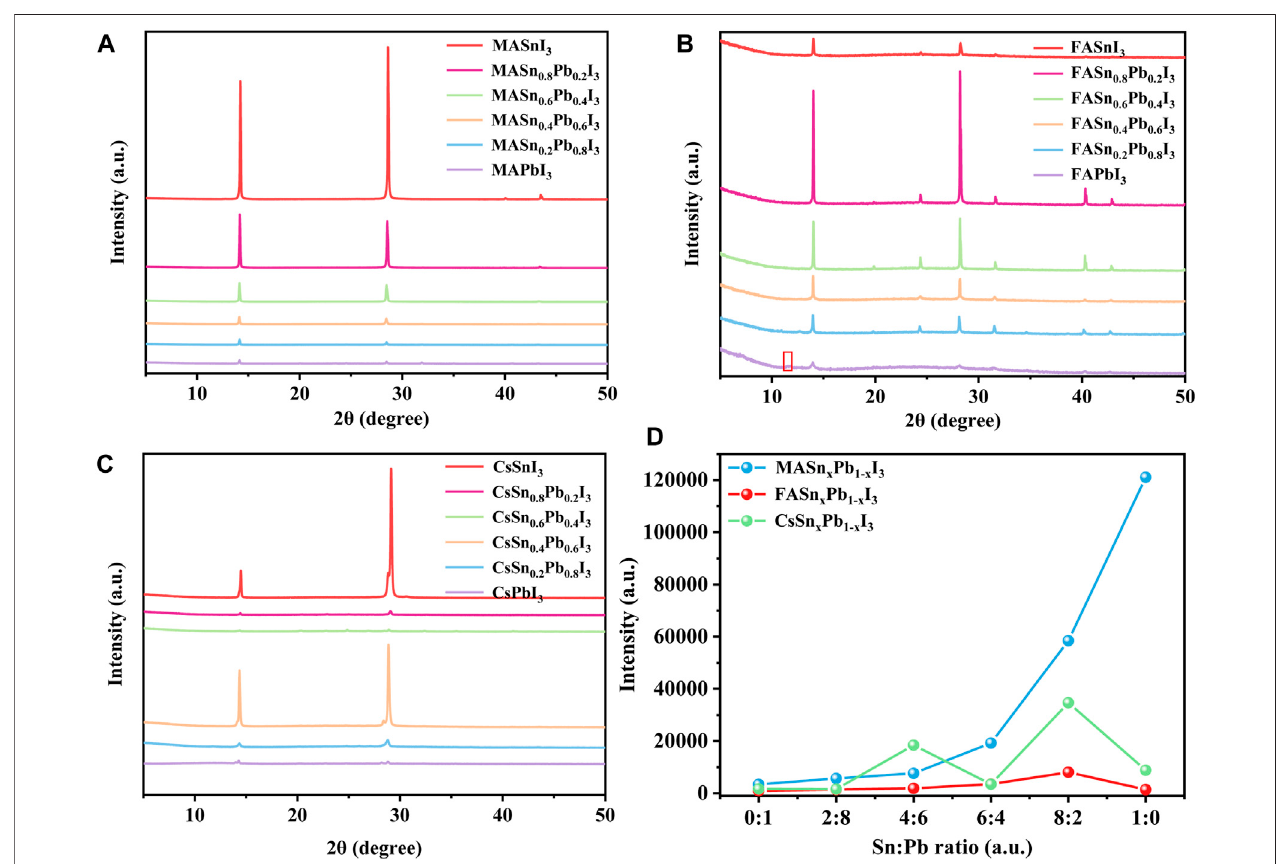
FIGURE 1 | XRD patterns of (A) MASn x Pb 1-x I 3 , (B) FASn x Pb 1-x I 3 and (C) CsSn x Pb 1-x I 3 ; (D) (110) peak intensity for each